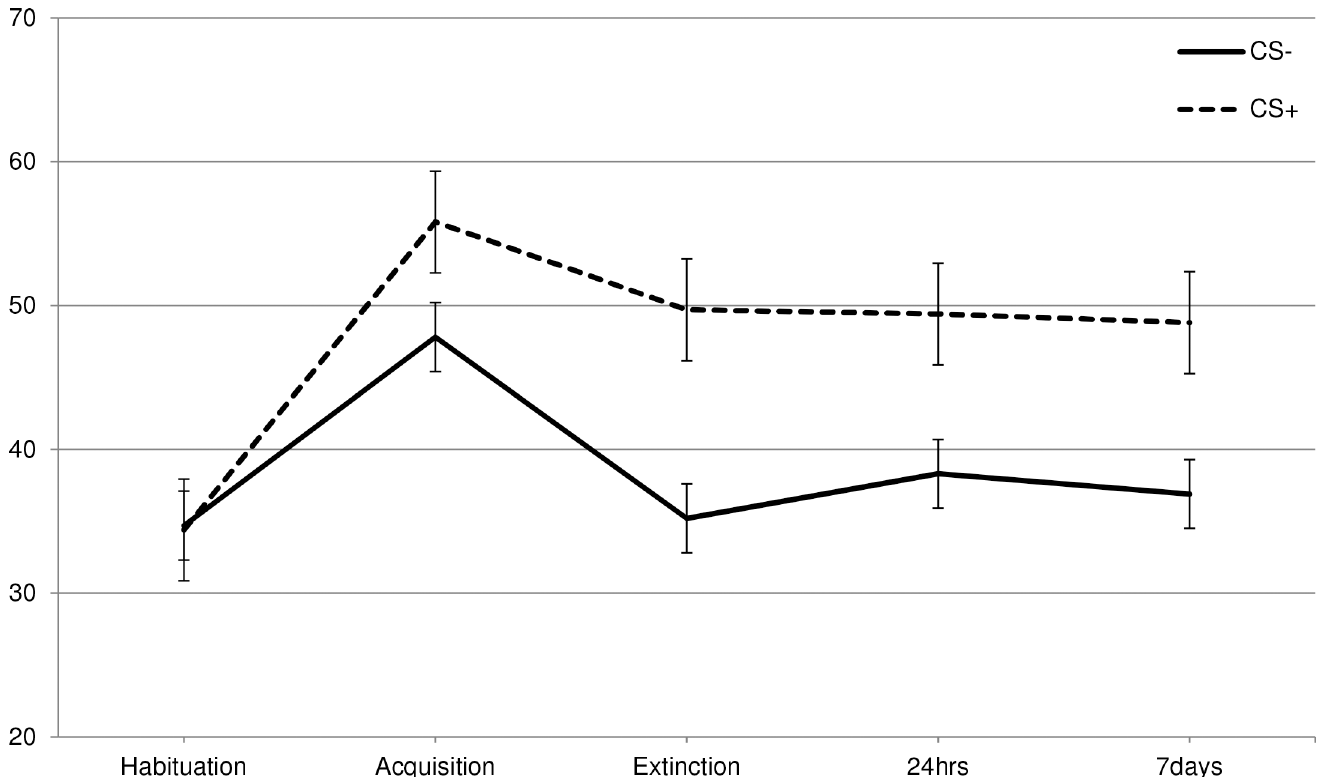
Fig 1. Self-reported disgust. Total scores in the different phases (habituation, acquisition, extinction, 24hrs and 7 days) of the self-reported